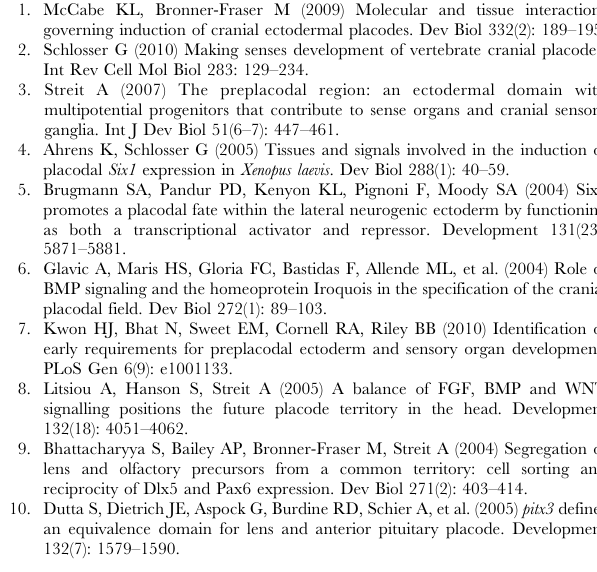
the otic/epibranchial domain in a wild-type embryo (A) and itga5 mutant (B). Otic placodes (o, brackets) are indicated. ( C, D ) neuroD expression at 14 hpf in a control embryo (C) and itga5 morphant (D). Precursors of the trigeminal ganglion (tg) and anterior lateral line (al) are indicated. ( E, F ) Immunolocalization of Pax2 (green) and Caspase 3 (red) in a wild-type embryo (E) and itga5 mutant (F). ( G, H ) Otic vesicles at 24hpf in a wild-type embryo (G) and itga5 mutant (H). ( I, J ) phox2a expression in epibranchial ganglia at 30 hpf in a wild-type embryo (I) and itga5 mutant (J). Facial (f), glossopharyngeal (g), and vagal ganglia (v1 + v2) are indicated. A–E are dorsal views with anterior to the top; G–J are lateral views with anterior to the left. Scale bar, 50 m m. Figure S2 Recruitment of lateral cells into the pax2- a:GFP domain. Representative frames from a movie of a pax2a:GFP transgenic embryo injected with cmv:RFP plasmid DNA. RFP-positive cells originating from a position lateral to the otic/ epibranchial domain were tracked as they entered the pax2a:GFP domain and activated expression of GFP. White arrows indicate the positions of two cells with respect to domains of GFP alone or both GFP and RFP. A map of the migration patterns of the two tracked cells is indicated, with the purple and green borders marking the initial and final positions, respectively, of the pax2a:GFP domain. Figure S3 Knockdown of itga5 does not alter prolifera- tion. Embryos were incubated in BrdU beginning at 11.5 hpf, fixed at 13.5 hpf and immunostained for BrdU (green) and Pax2a (red). Figure S4 Knockdown of itga5 does not perturb cell migration in more lateral regions. Maps of migration patterns of RFP-positive cells observed in movies of a pax2a:GFP/ + control embryo and a pax2a:GFP/ + embryo injected with itga5- MO. Embryos were injected with cmv:RFP plasmid at the one-cell stage and imaged from 11.5 hpf to 14.5 hpf. In the itga5 morphant, lateral cells migrated normally for most of the filming period. Two cells showed deviations only after nearing the otic/epibranchial domain where itga5 expression normally upregulates. Nevertheless,